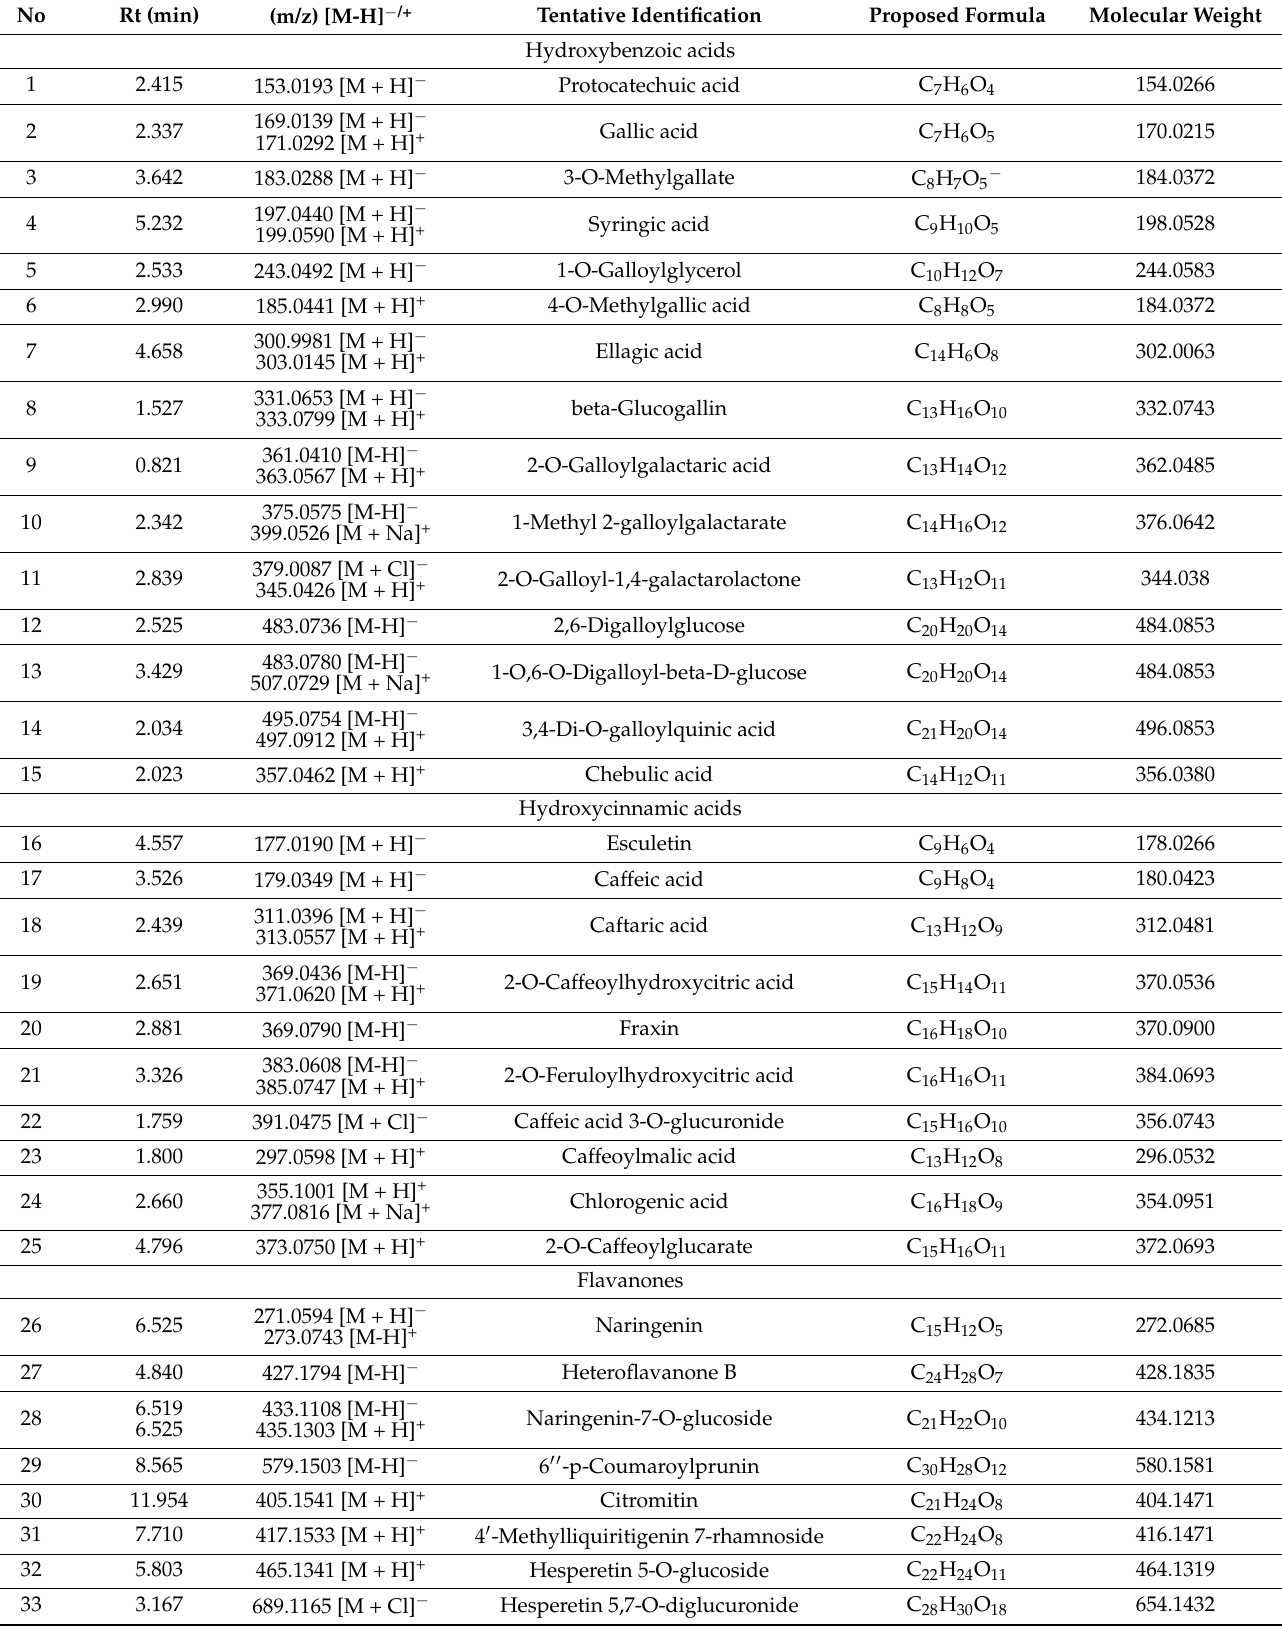
Table 2. Phenolic compounds tentatively identified in PE fruit via UPLC-ESI-QTOF-MS in positive and negative ionization